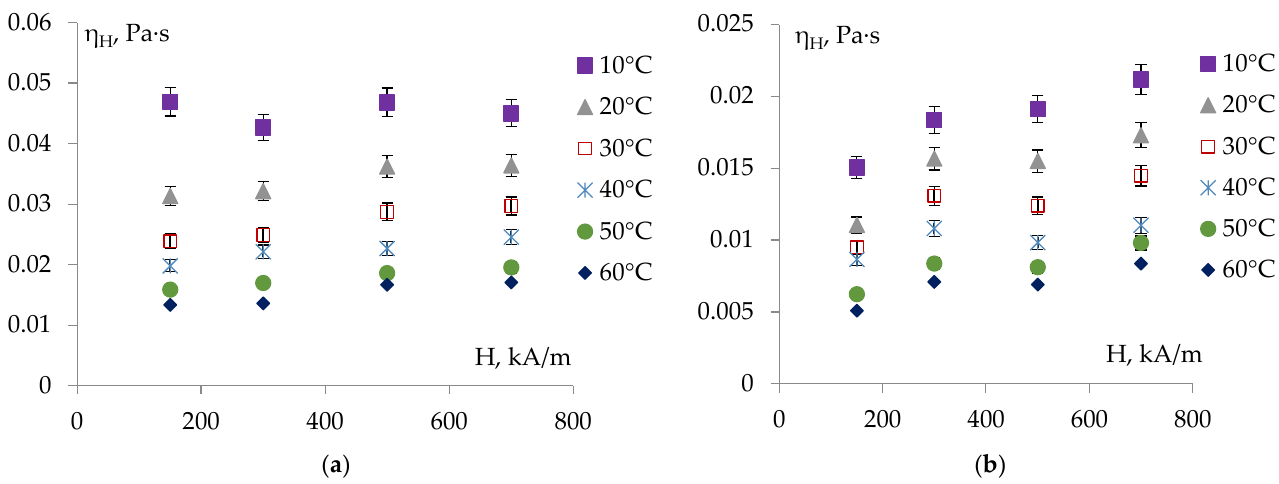
Figure 9. Dependence of the magnetic fluid viscosity on the magnetic field strength: ( a ) MF-10, ( b ) MF-11.